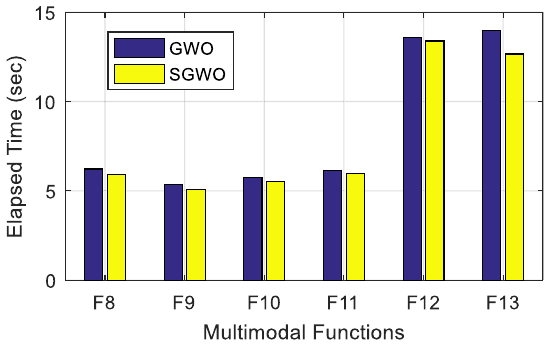
Fig. 7 Multi-modal function ’ s execution time comparison of GWO and SGWO technique